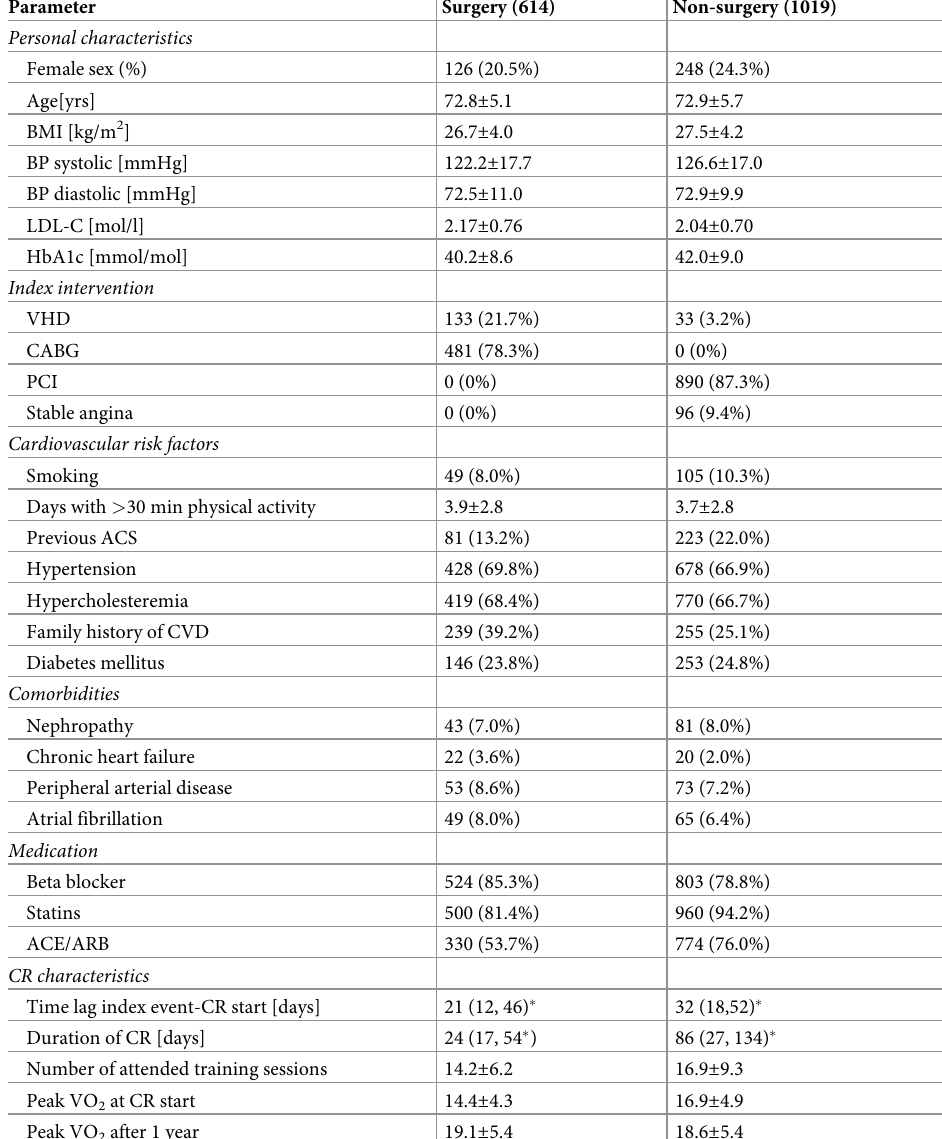
Table 1. Baseline characteristics of surgery and non-surgery patients.